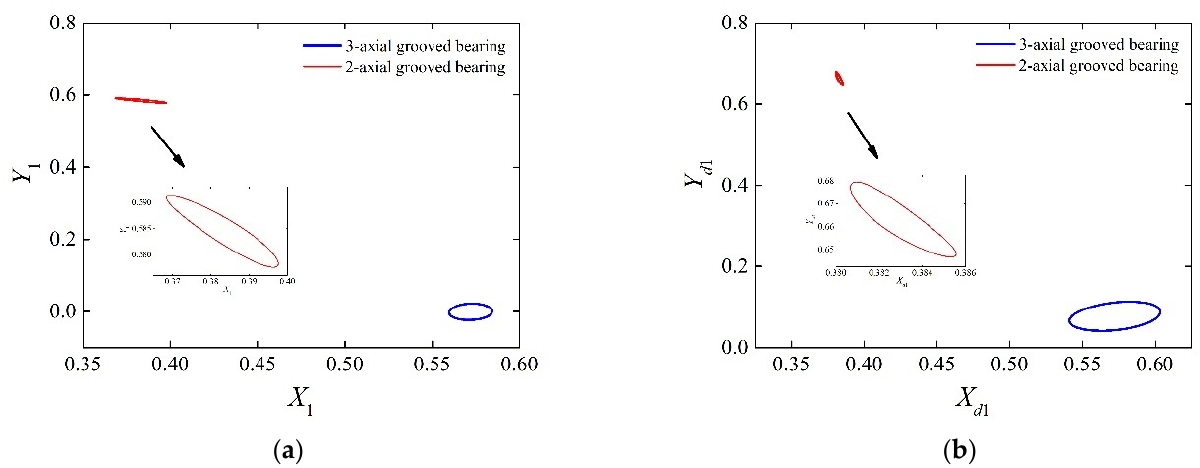
Figure 13. When ω = 1500 rad/s, comparison of the rod–fastened rotors with 3-axial grooved and 2-axial grooved gas bearings: ( a ) comparison of the orbits at the left bearing station; ( b ) comparison of the orbits at the left disk station.